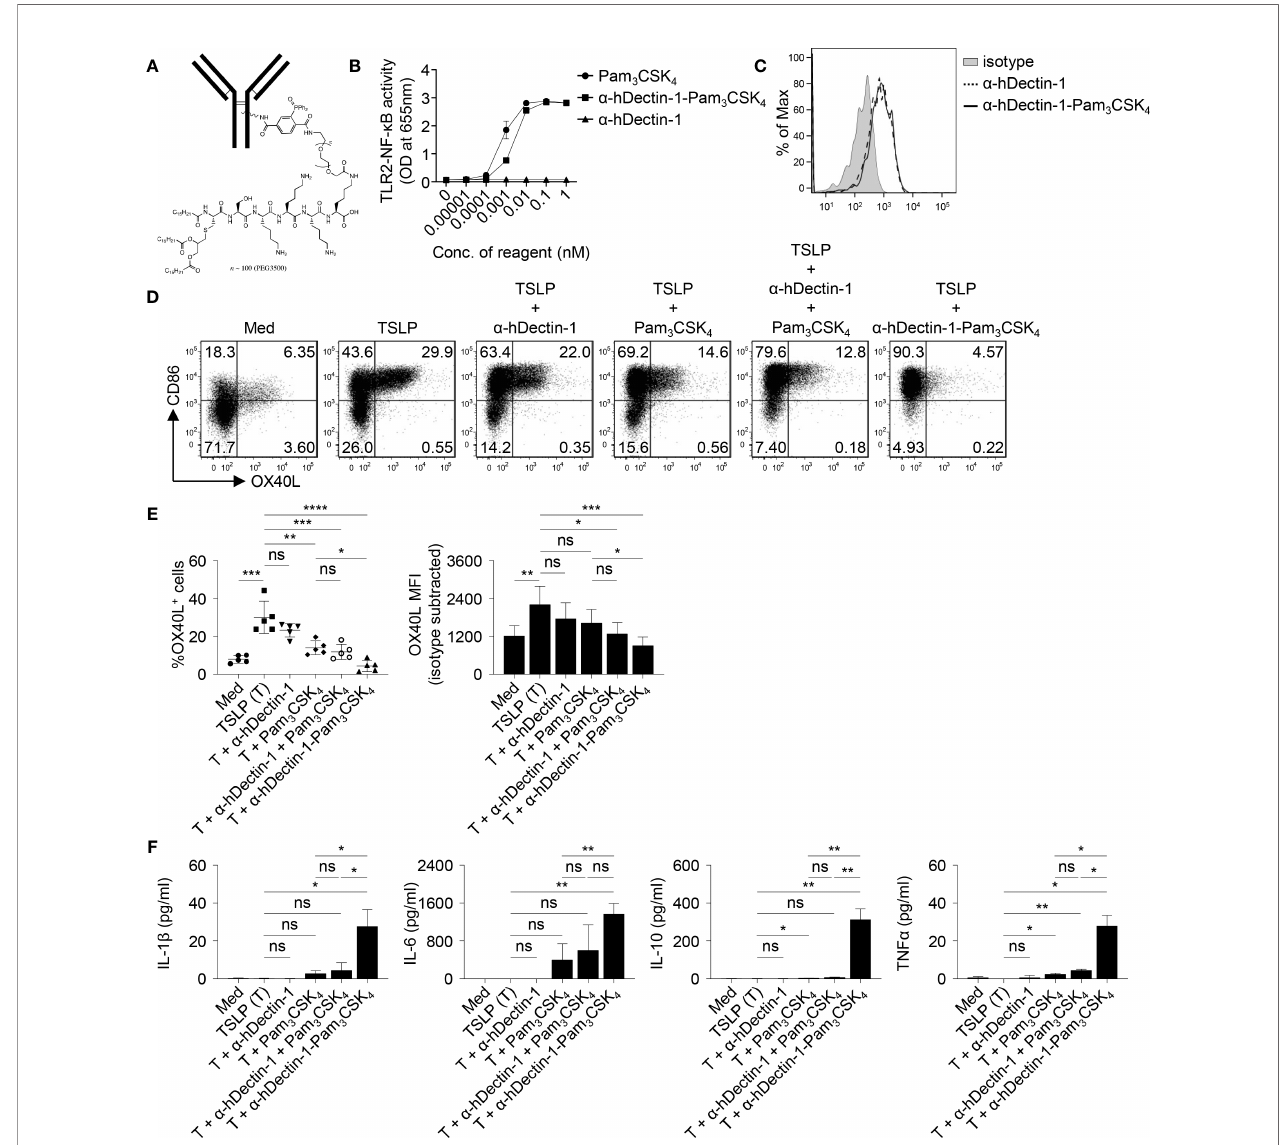
FIGURE 6 | Anti-hDectin-1-Pam 3 CSK 4 Conjugate Suppresses TSLP-Induced OX40L Expression by mDCs. (A) Diagram of anti-hDectin-1-Pam 3 CSK 4 conjugate structure. (B) Anti-hDectin-1-Pam 3 CSK 4 conjugate preserved TLR2 agonistic property in HEK-Blue TLR2 reporter assay. Summarized data of test with triplicate samples are shown. (C) Anti-hDectin-1-Pam 3 CSK 4 conjugate bound to human mDCs similar to its mAb precursor. Representative FACS data of three experiments is shown. (D, E) Anti-hDectin-1-Pam 3 CSK 4 conjugate suppressed TSLP-induced OX40L expression by human mDCs. Representative FACS data (D) , summarized data of % of OX40L + mDCs ( E , left panel) and mean fl uorescence intensity (MFI) of OX40L expression ( E , right panel) from different donors (n = 5) are shown. (F) Cytokine concentration in culture supernatants of mDCs (n = 4) after stimulation with indicated reagents was analyzed by multiplex assay. Data in (B, E, F) are represented as mean ± SD. Signi fi cance was determined using one-way ANOVA with Tukey multiple comparisons test for (E, F) . * p < 0.05, ** p < 0.01, *** p < 0.001, **** p < 0.0001 for the comparison between groups. ns, not signi fi